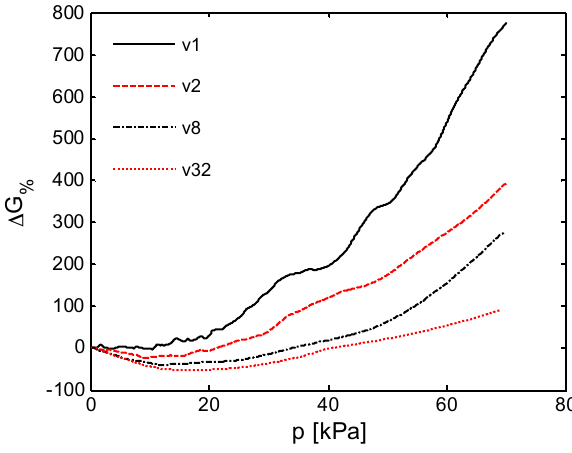
Figure 14. Relative percentage conductance variation as function of the applied pressure p at different crosshead speed ( v 1 = 1 mm/min, v 2 = 2 mm/min, v 8 = 8 mm/min, v 32 = 32 mm/min).